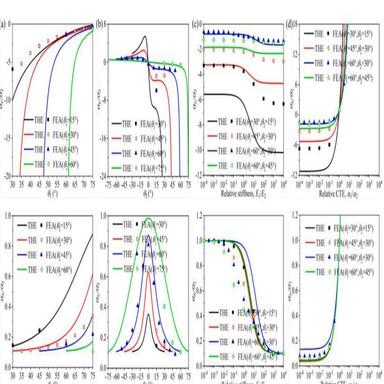
Theoretical and numerical results of αy/α2 and αx/α2 of composite 3D DVH lattices as functions of (a) θ1 (E1/E2 = 100 and α1/α2 = 0.1), (b) θ2 (E1/E2 = 100 and α1/α2 = 0.1), (c) E1/E2 (α1/α2 = 0.1) and (d) α1/α2 (E1/E2 = 100) with t1/l = t2/l = b/l = 0.1.